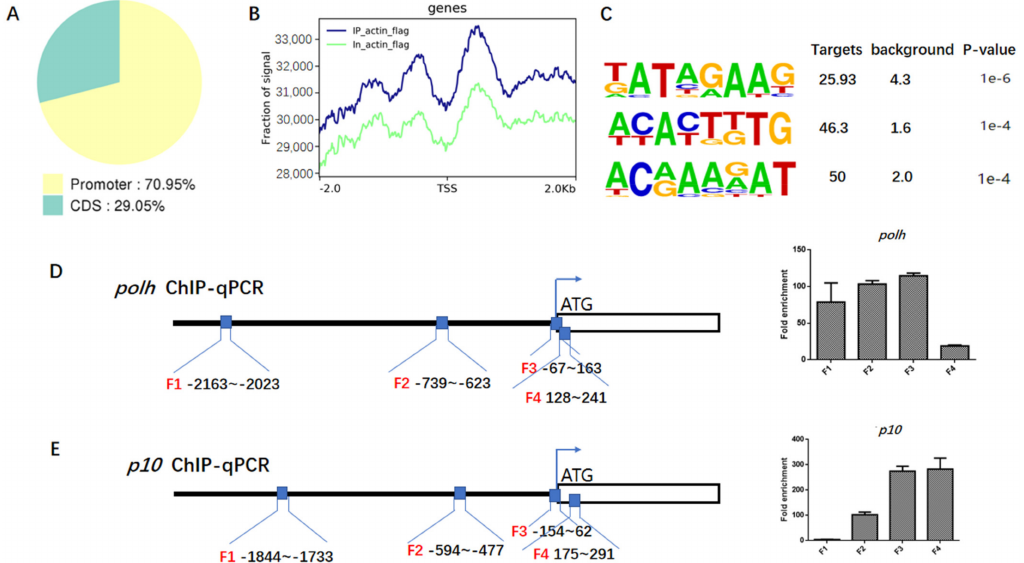
Figure 4. ChIP-seq and ChIP-qPCR analysis. ( A ) Statistics of distribution of actin-binding sites in the virus genome. ( B ) Distribution of actin-binding sites in the genic regions of the recombinant virus Bm- actin-Flag. ( C ) The top four most highly enriched motifs of actin in viral gene. Information regarding the most significant motifs of viral genes identified in the actin-binding peaks with Multiple EM for Motif Elicitation (MEME). ( D , E ) Verification of the ChIP-Seq results by ChIP-qPCR including four regions upstream of polh and p10 TSS. The primer pairs used in the RT-qPCR assay are represented with black lines (black boxes from left to right are F1 to F4). Enrichment of target DNA was represented as a percentage of input DNA. The values in each column are the means of three independent replicates and error bars represent the